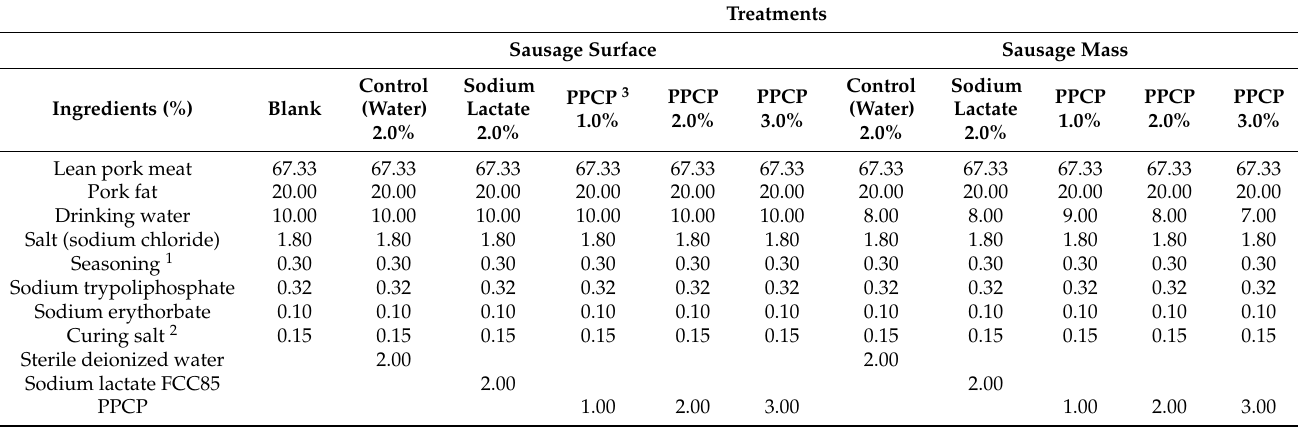
Table 1. Formulation of pork sausage